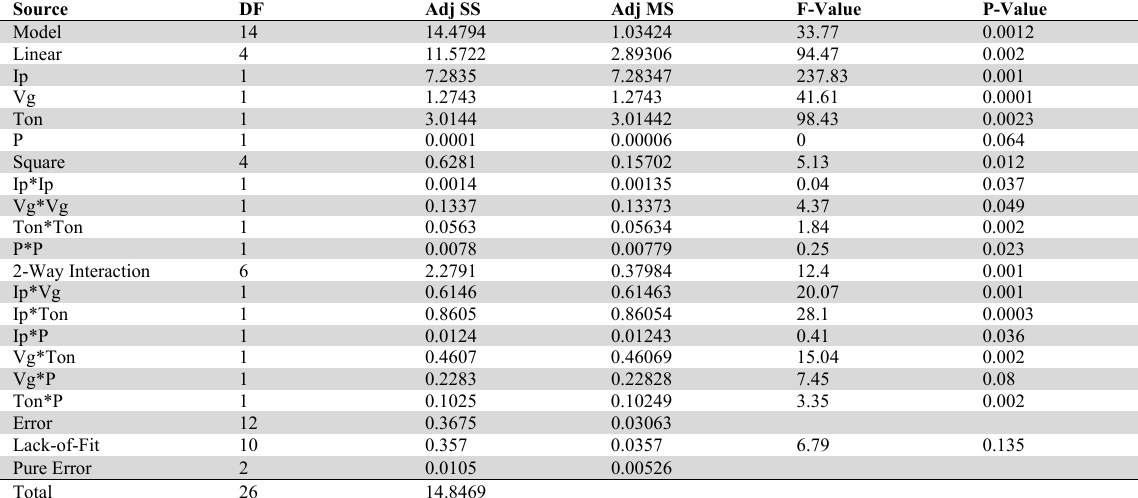
Analysis of variance table for